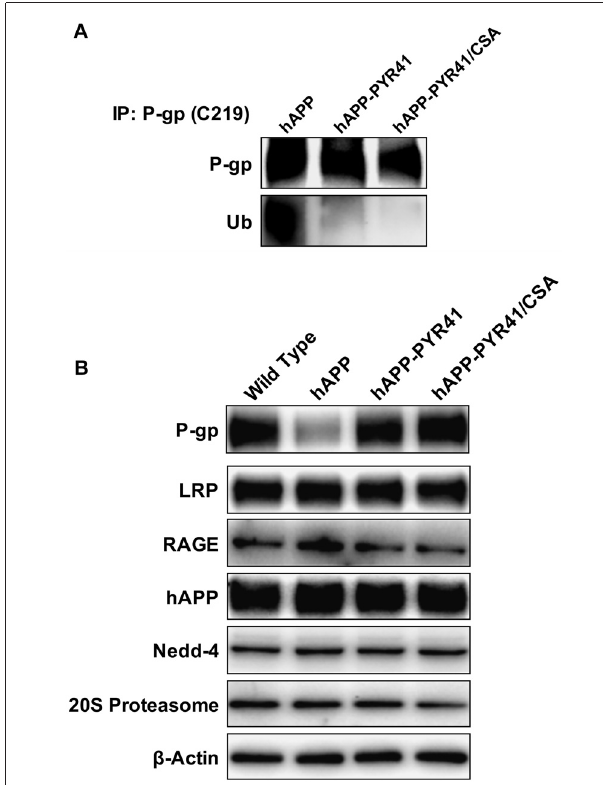
FIGURE 4 | PYR41 prevents P-gp ubiquitination in hAPP mice. (A) Western blot showing that treating hAPP mice with PYR41 reduces ubiquitin levels in P-gp-immunoprecipitates from isolated brain capillaries. P-gp was immunoprecipitated in capillary samples isolated from hAPP, hAPP-PYR41 and hAPP-PYR41/CSA mice, and examined for P-gp and ubiquitin levels by Western blotting (brain capillaries isolated from pooled tissue; n = 15 mice per treatment group). (B) Western blot showing that PYR41 and PYR41/CSA treatment of mice had only an effect on P-gp protein expression levels, whereas levels of LRP, RAGE, hAPP, Nedd-4 and the 20S proteasome were not affected in isolated brain capillaries (pooled tissue; n = 15 mice per treatment group).